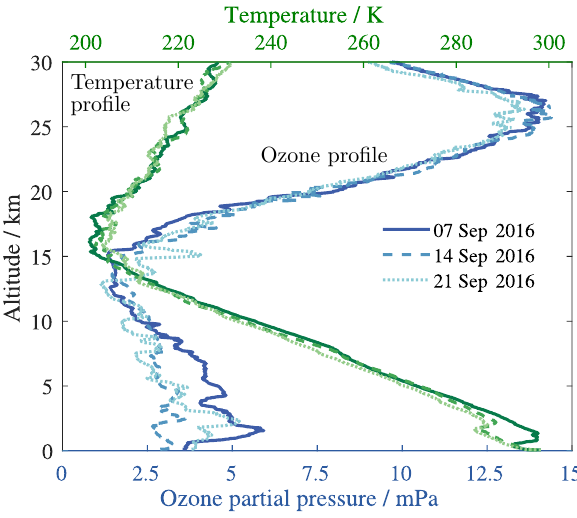
Figure 1. Temperature and ozone profiles as a function of the alti- tude measured with a sonde during the ATMOZ field measurement